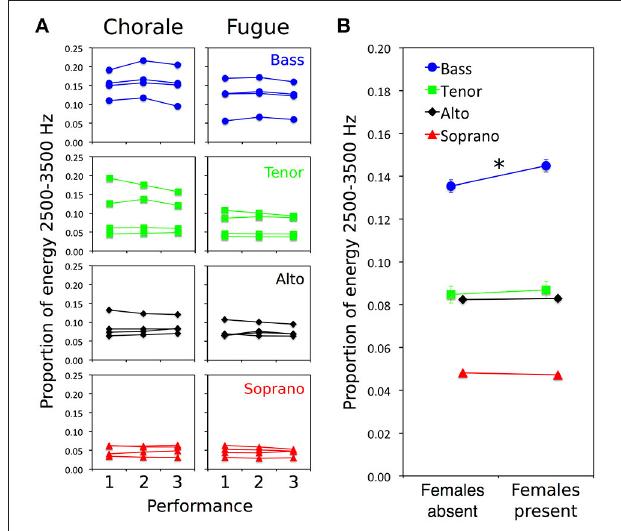
FIGURE 2 | Effects of female presence on spectral energy (based on audio signals) in the voices of individual male singers for two distinctive pieces of choir music. (A) Proportion of energy in the singer’s formant region for individual singers in each voice section for three performances of each piece, a chorale (left) requiring rhythmic synchrony between choir sections and a fugue (right) requiring rhythmic independence between sections. Performance 1 was sung to the male audience, performance 2 to the audience with additional females, and performance 3 to the male audience again. Separate plots are shown for basses (blue circles), tenors (green squares), altos (black diamonds), and sopranos (red triangles). For both pieces, there is an increase in energy from performance 1 to 2 (when females present), followed by a decrease in performance 3, for each of the four basses, but no such consistent effect in other voice sections. (B) Proportion of total energy in the singer’s formant region for each voice part (averaged across individual singers and pieces) when females were present vs. absent. Proportion of energy is higher when females were present than absent only in basses (female presence × voice type interaction, p = 0.003; asterisk indicates p = 0.016 for simple effect of female presence for basses only). Error bars are 95% confidence intervals based on within-participants s.e.m. (bars occluded by data marker symbols for sopranos and altos).